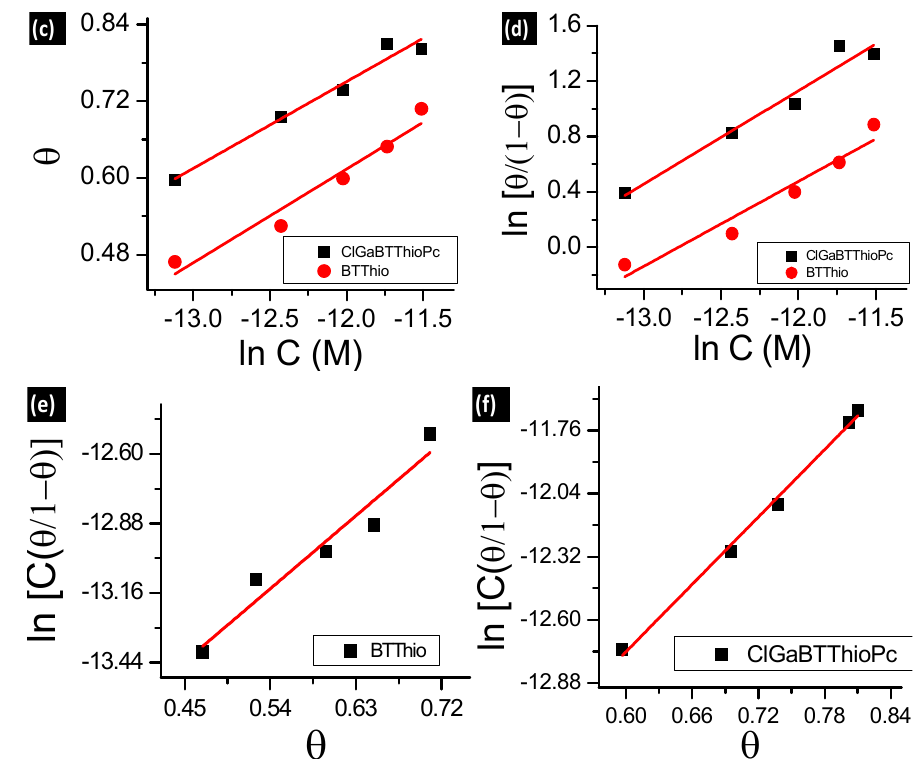
Figure 4. ( a ) Langmuir; ( b ) Freundlich; ( c ) Temkin; ( d ) El-Awady; ( e , f ) Frumkin adsorption (for BTThio and ClGaBTThioPc, respectively) isotherm plots at 28 °C.